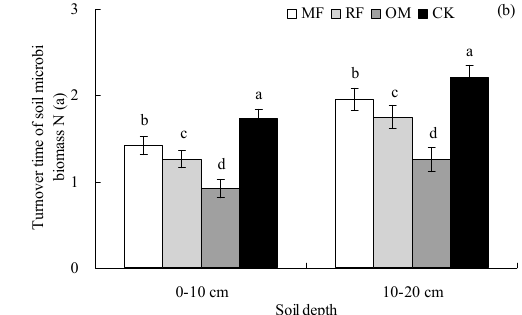
CK Figure 3. Effects of different long-term fertilizer treatments on flux turnover rates of soil microbial